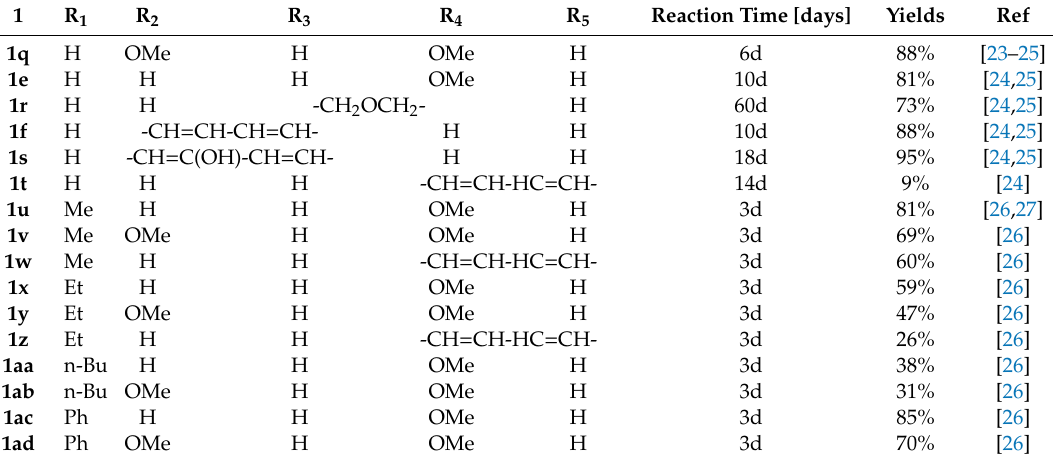
Table 2. Results from the reactions of 2-diethoxyphosphorylacrylates 12 with substituted phenols or naphthols 13 in the presence of strong acids.